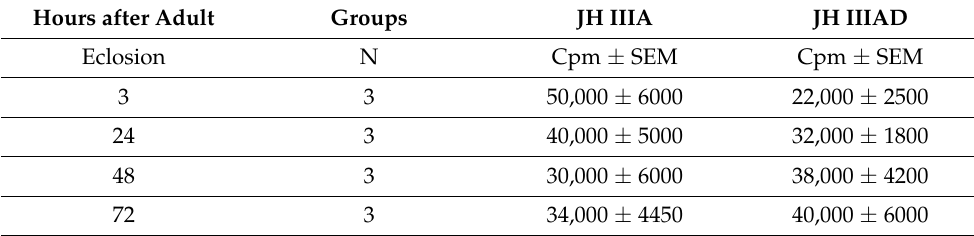
Table 2. In vivo metabolism of [12- 3 H]JH IIIA in female D. melanogaster . Hours after Adult Groups JH IIIA JH IIIAD Eclosion N Cpm ± SEM Cpm ± SEM 3 3 50,000 ± 6000 22,000 ± 2500 24 3 40,000 ± 5000 32,000 ± 1800 48 3 30,000 ± 6000 38,000 ± 4200 72 3 34,000 ± 4450 40,000 ±